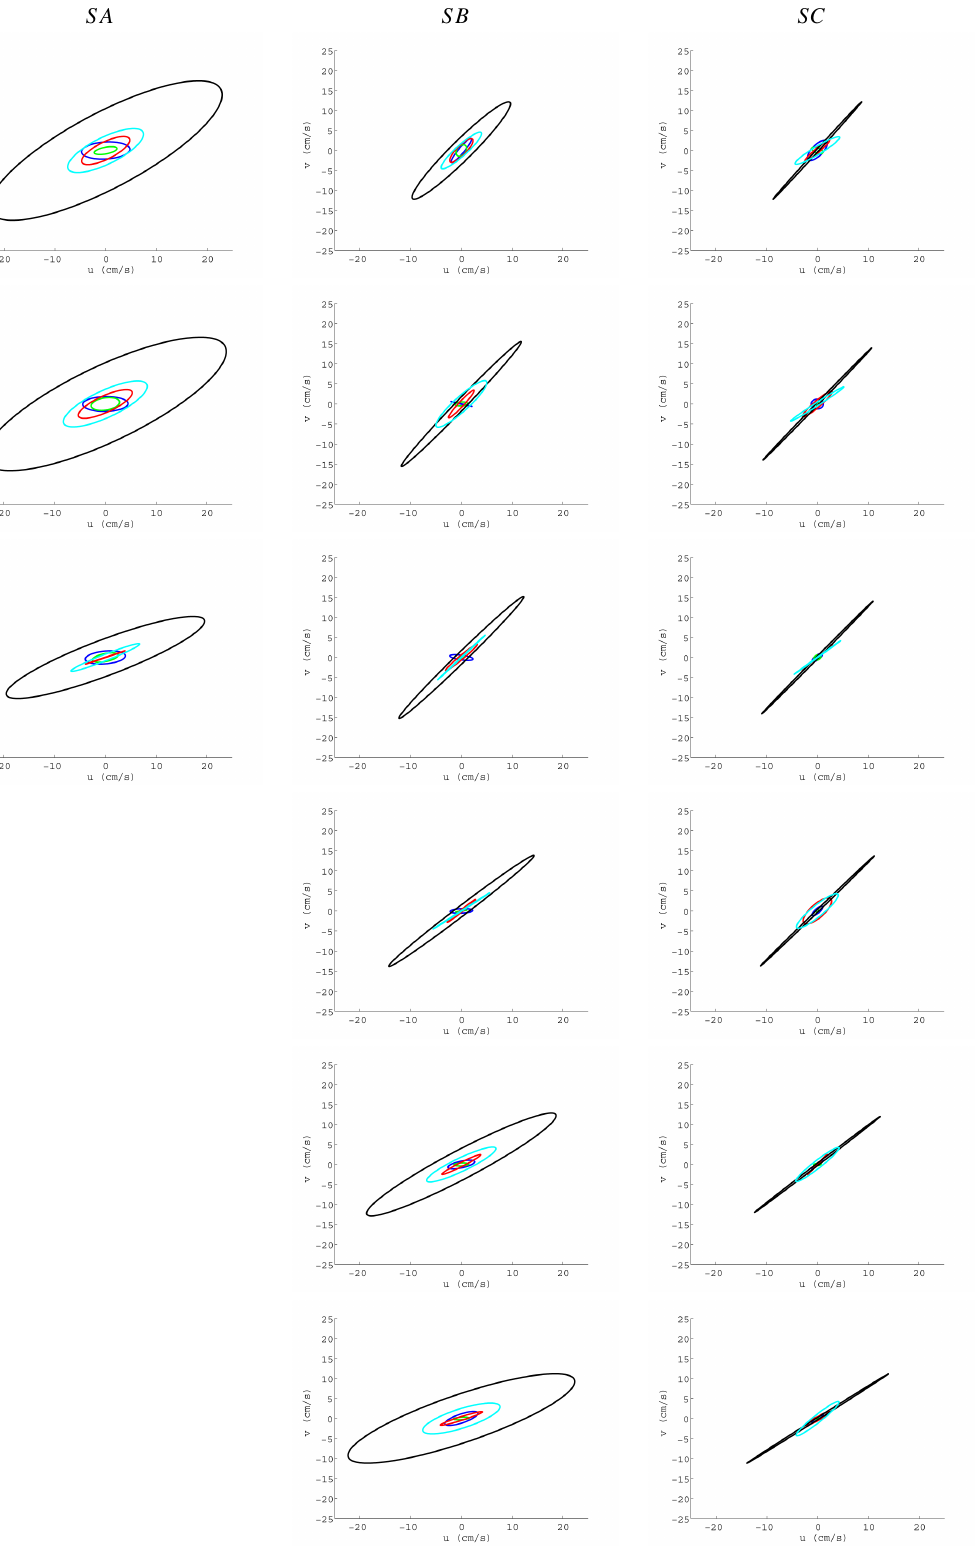
Fig. 10. Variation of tidal constituents ( M 2 black, S 2 cyan, N 2 red, O 1 blue and K 1 green) with depth (from top to bottom at about 220, 320, 420, 520, 620, and 720m depth) and space in the FSC